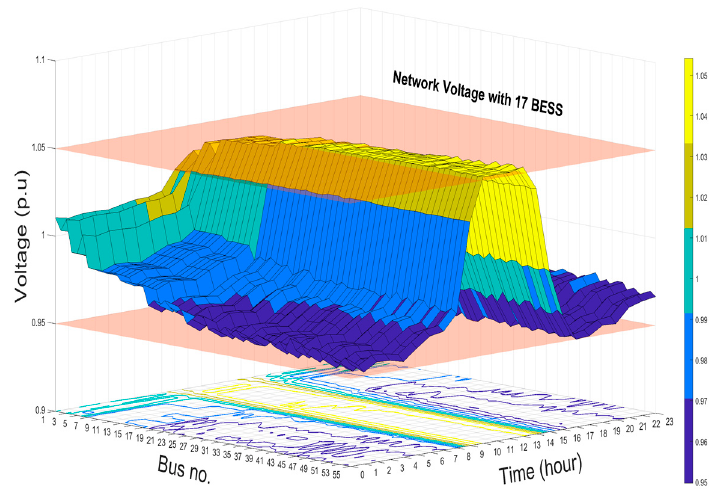
Figure 11. Network voltage profile with 5 BESS installed.